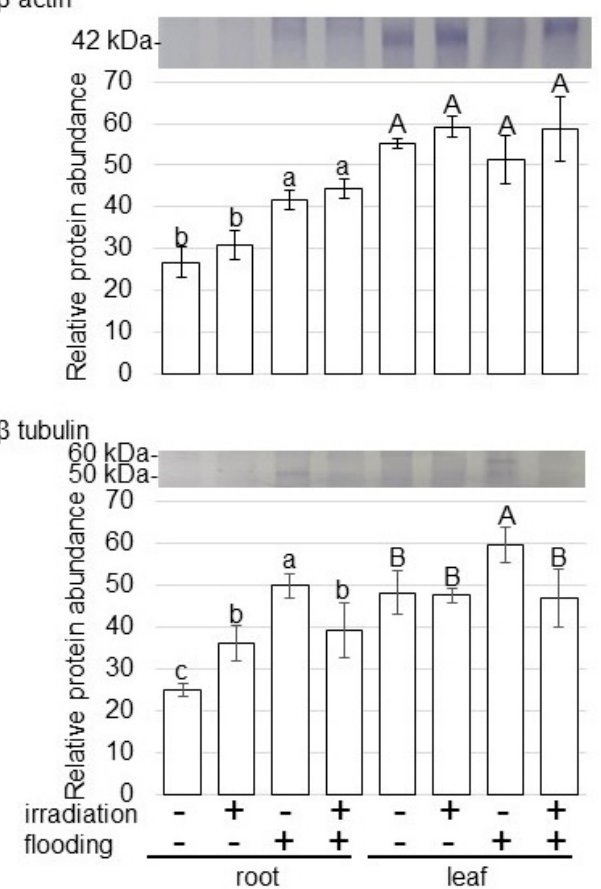
Figure 7. Immunoblot analysis of proteins involved in cell organization in wheat irradiated with millimeter waves under flooding stress. Proteins extracted from root and leaf of wheat seedlings were separated on SDS-polyacrylamide gel by electrophoresis and transferred onto membranes. The membranes were cross-reacted with anti- β actin and β tubulin antibodies. Staining pattern with Coomassie-brilliant blue was used as loading control (Figure S4). The integrated densities of bands were calculated using ImageJ software. The data are given as the mean ± SD from three independent biological replicates (Figures S11 and S12). The statistical analysis is same as Figure 4.